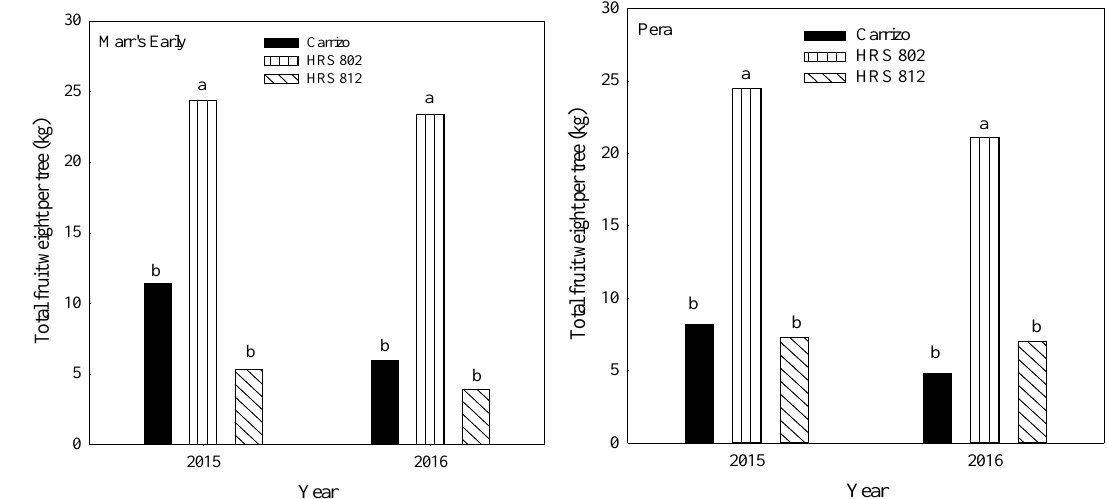
Figure 4. Total fruit weight per tree in 2015 and 2016 of ‘Marr’s Early’ and ‘Pera’ sweet orange cultivars grafted on three different rootstocks growing on Alonso clay series soil at the Agricultural Experiment Substation of Adjuntas, Puerto Rico. Means with different letters for each scion and year are not significantly different using Tukey’s test at α < 0.05.